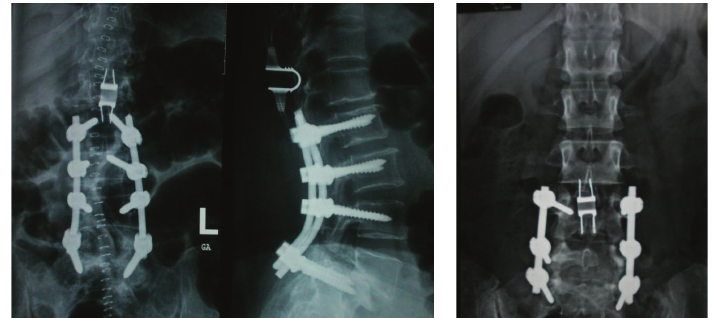
Figure 3: Postoperative spine X-ray, on the right, showing multiple level fusions with ISD 1 level skipping the adjacent segment. On the left, ISD used at the level adjacent to the rigid